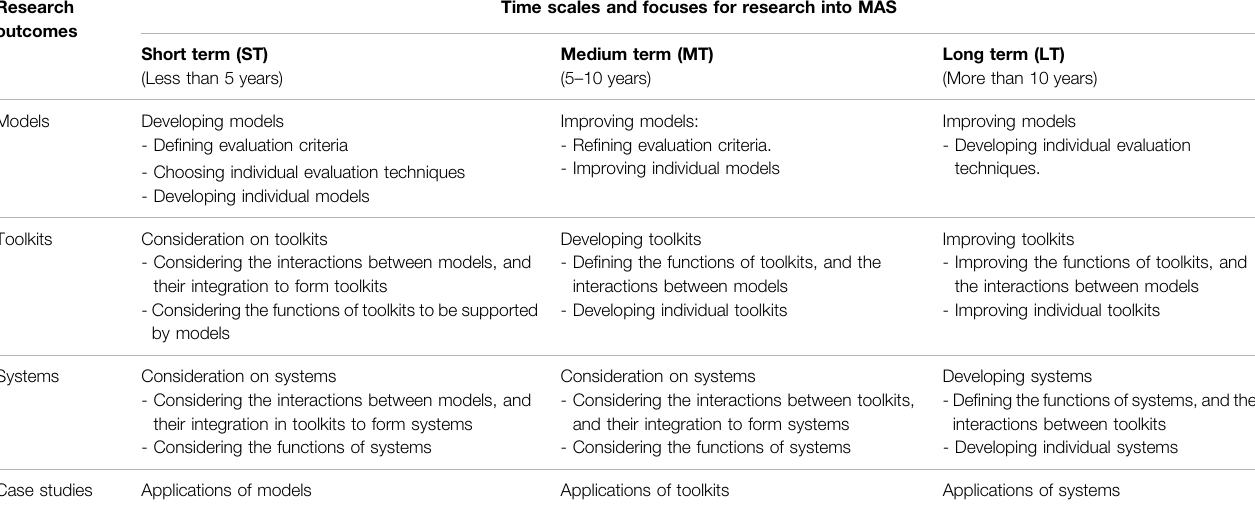
Time scales and focuses for research into MAS